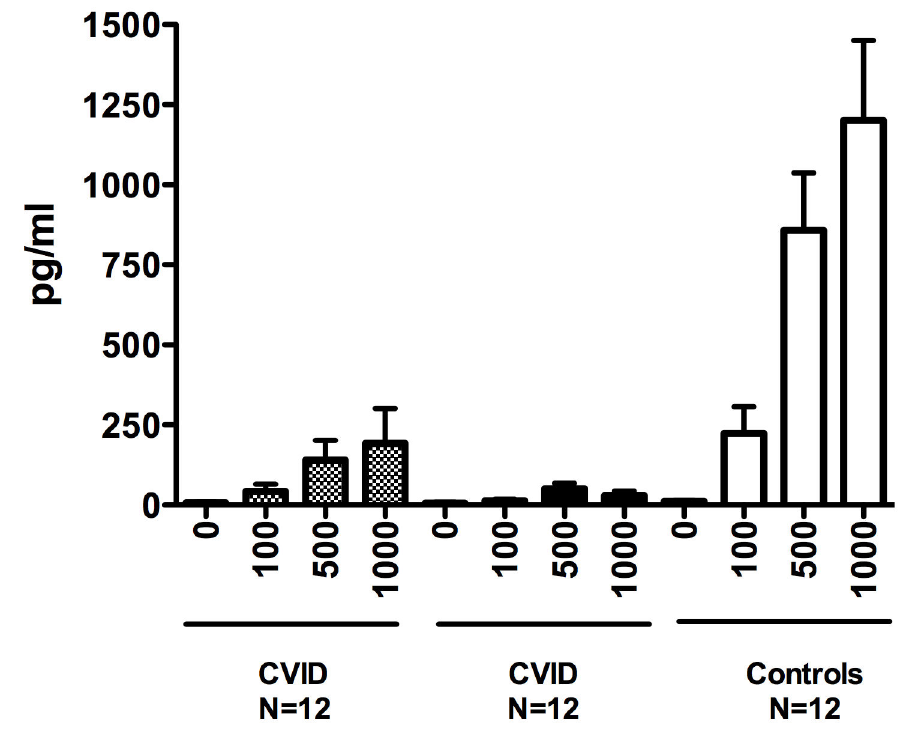
Figure 11. Production of IFN-α. For IFN-α production, PBMCs from control subjects (10) and CVID subjects with (+) and without inflammatory (-) complications, were stimulated with increasing amounts of loxoribine. IFN-α in supernatants was assessed by ELISA. doi: